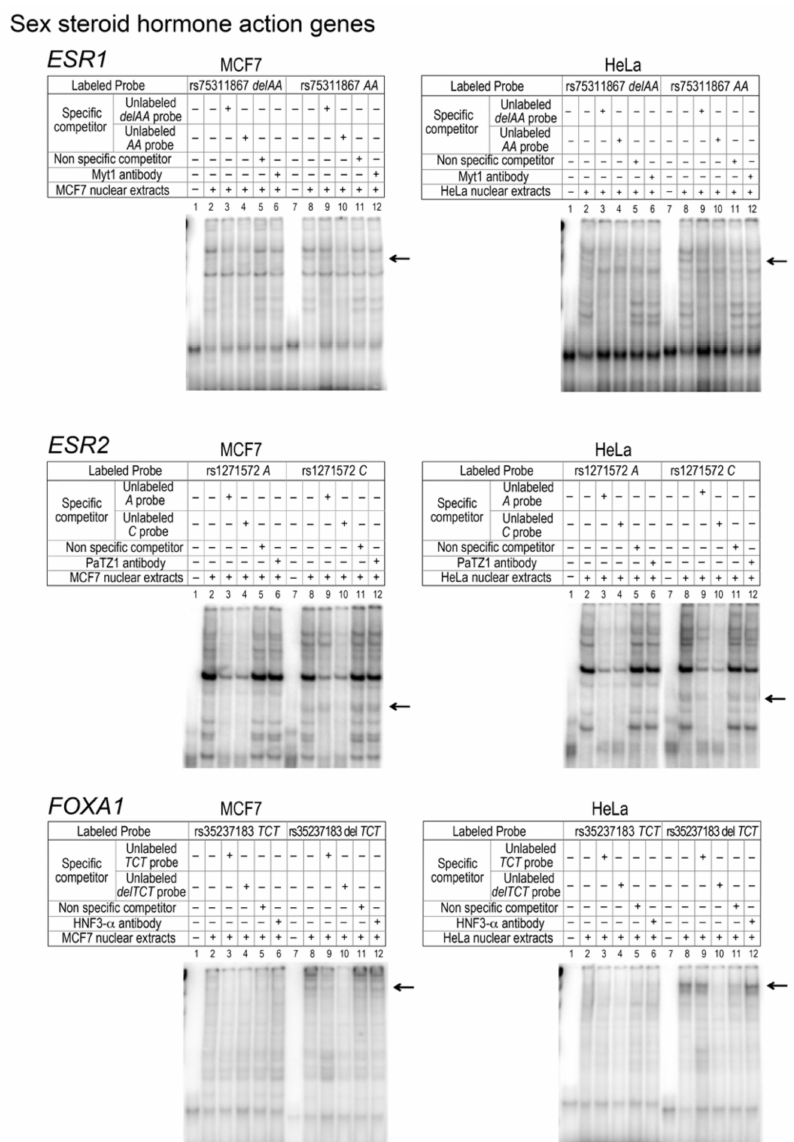
Figure 3. Representative EMSA analysis showing DNA–protein interactions in the promoter region of the selected genes involved in sex steroid hormone action. ESR1 , ESR2 and FOXA1 as genes related to sex steroid action pathway. Labeled double-stranded oligonucleotide probes for each of the respective variants tested were incubated with nuclear extracts from MCF7 and HeLa cells. The unlabeled probes used to determine non-specific radioisotope binding (at a 50-fold molar excess) are indicated for each lane. Specific competitors corresponding to the unlabeled allele-specific probes and a non-specific double-stranded oligonucleotide competitor were used for each experiment. Fast-migrating unbound probes are found at the bottom of the gel whereas protein–DNA complexes formed display a slower mobility. Black arrows indicate probe-specific differential protein binding. The Protein Atlas (https: //www.proteinatlas.org) and ProteomicsDB (https://www.proteomicsdb.org) databases report protein expression data for hepatocyte nuclear factor 3 (HNF3) in HeLa cells, and PATZ1 in both HeLa and